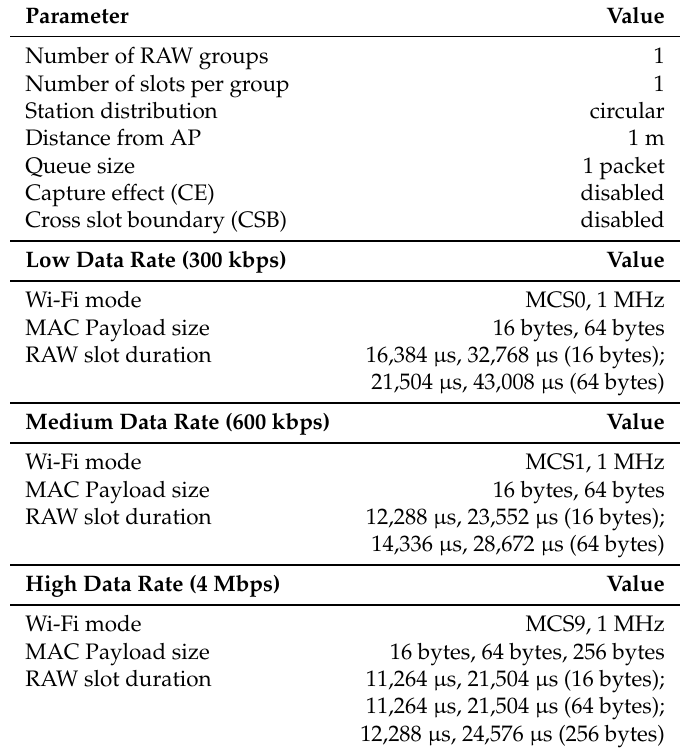
Table 4. Configuration for the comparison of numerical and simulation